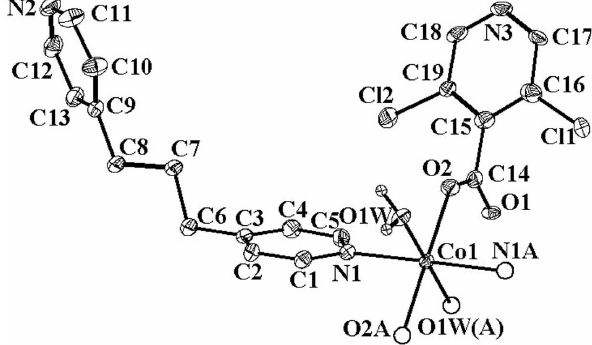
Table 1: Data collection and